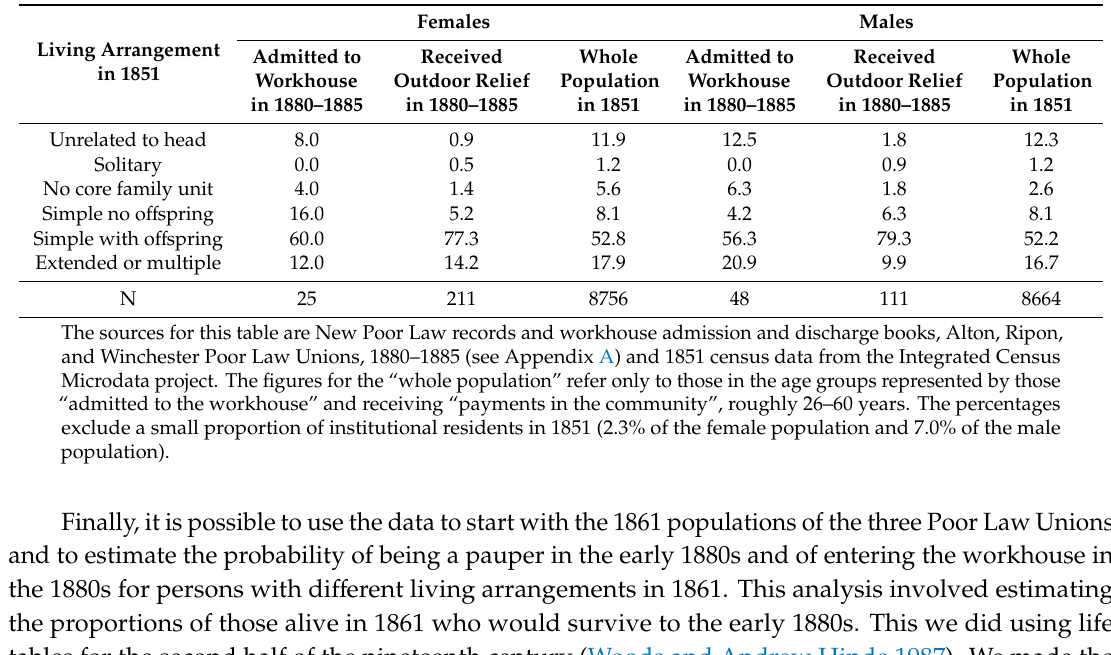
Table 5. Percentages with various living arrangements in